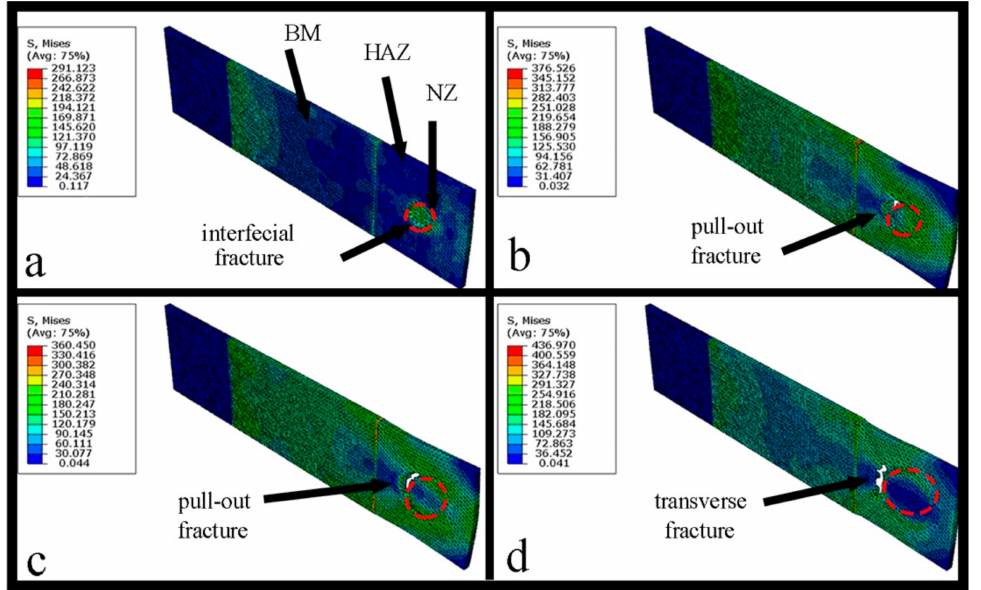
Figure 2. The simulated tensile-shear test of a copper spot-welded joint with a nugget diameter of